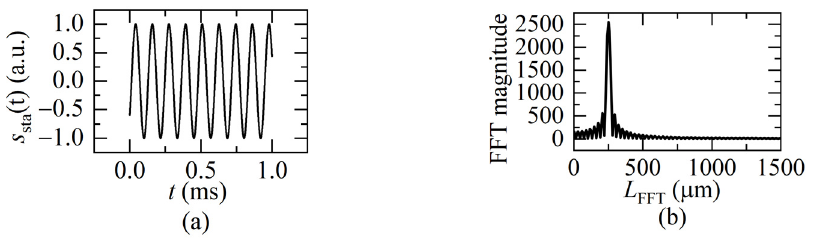
5 of 12 Figure 4. The residual error. ( a ) L error versus sweeping rate; ( b ) L error versus the acceleration a ( Δ u = 5.1 × 10 12 Hz, u a = 1.9365 × 10 14 Hz, v = 0.1 m/s, a = 0.1 m/s 2 , f sweep = 60 KHz).